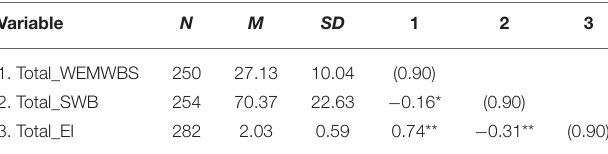
TABLE 2C | Totals for scales’ descriptive statistics and Pearson correlation coefficients’ statistics for Indian sample. Variable